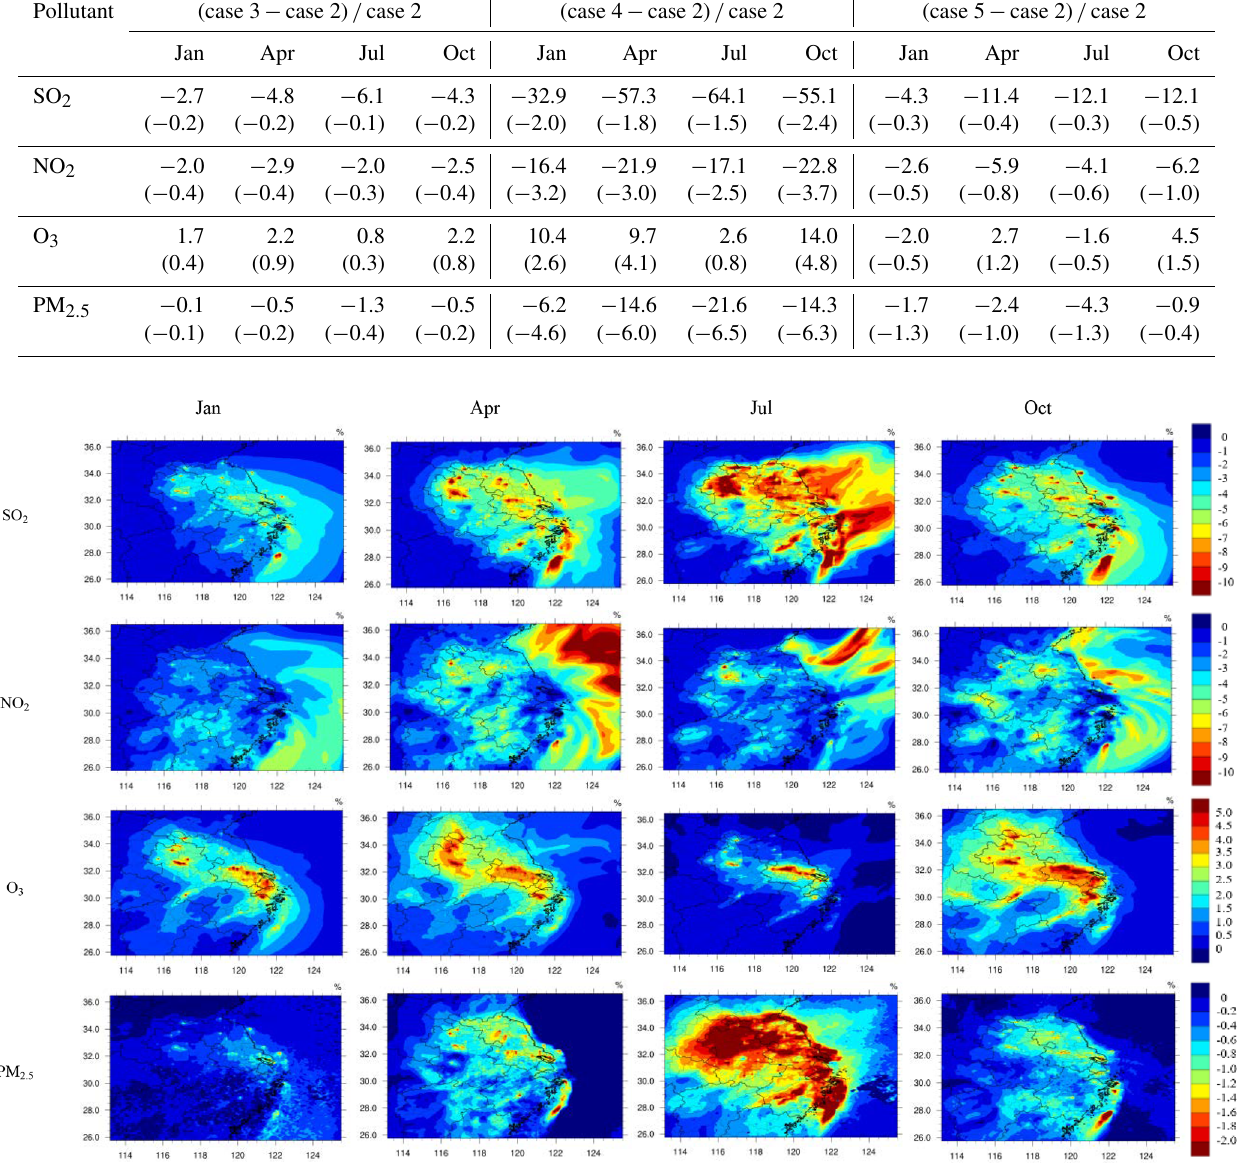
Table 3. The relative (%) and absolute changes (µgm − 3 , in parentheses) of the simulated monthly pollutant concentrations in different cases relative to case 2 in the YRD region.